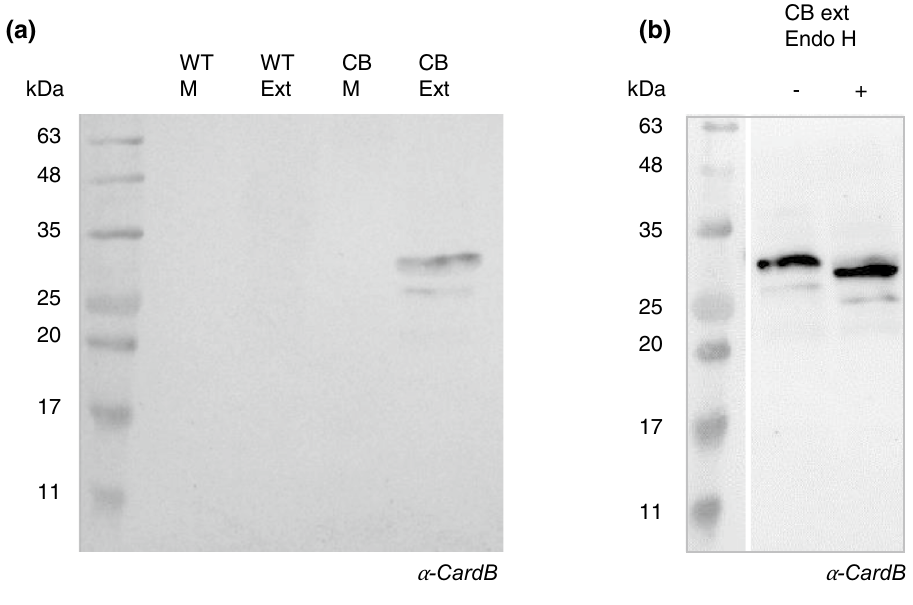
Figure 1. Detection of cardosin B heavy-chain by western blot. ( a ) Western blot of spent medium and cellular extracts of WT and CardB lines. ( b ) Endoglucosidase H assay using cellular extract of cardB lines. WT M—wild